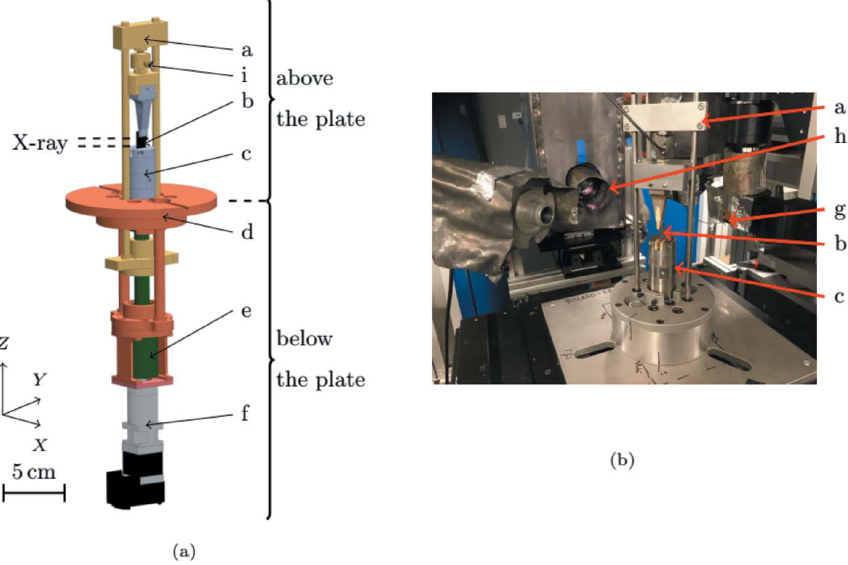
Figure 2 Experimental device: ( a ) CAD-rendering. ( b ) Implementation at the PSICHE beamline (King et al. , 2016). The sample b is clamped in the lower jaw c . Load is applied by a gantry a which passes through the frame d clamped to a tomograph rotating plate so that the actuator e + f is deported under the plate to reduce unbalance and free the observation zone. g is the tomograph scintillator, h is the infrared camera and i the force